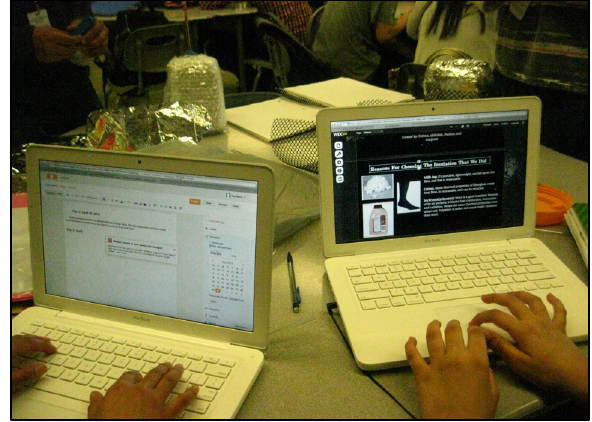
Figure 5. Example of one student's design in paper.